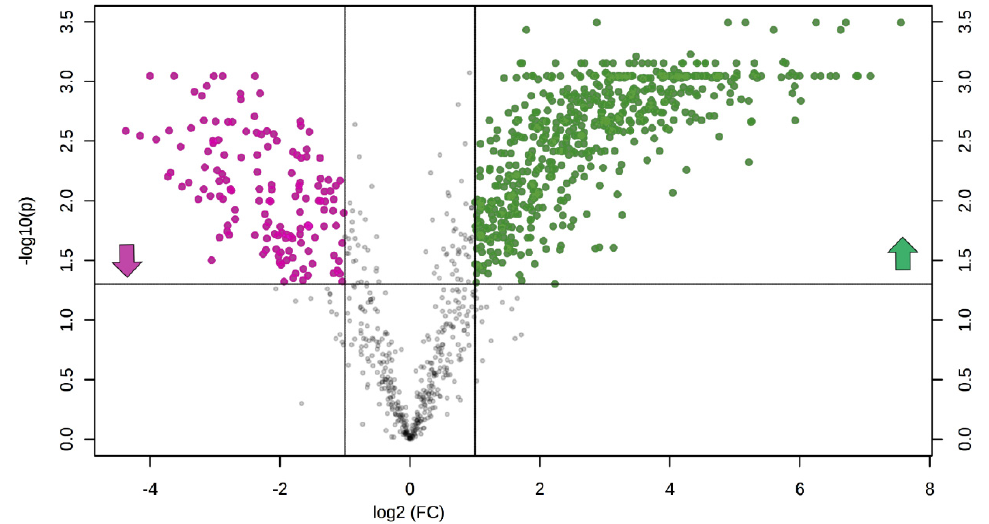
Figure 3. The volcano plot is a combination of fold change and t -tests: X -axis is log 2 (fold change, FC), and Y -axis is − log 10 (adjusted for false discovery rate). Dots indicate features that presented both a FC >2 and p -value < 0.05. Lipids in pink and green are reduced (n.118) and augmented (n.514) in CF vs. H, respectively.